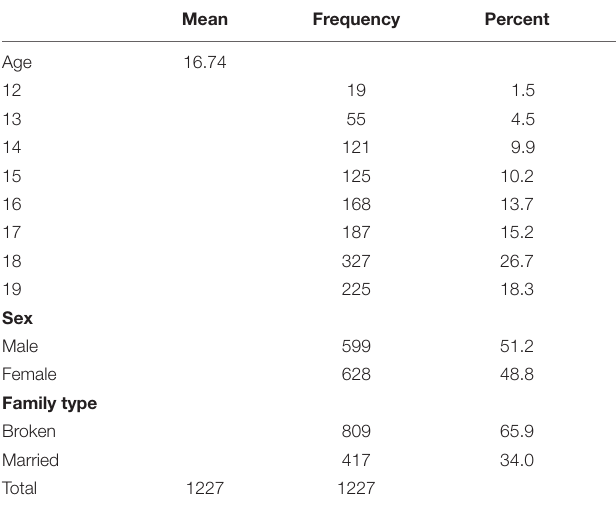
TABLE 1 | Descriptive statistics of the sociodemographic characteristics of the